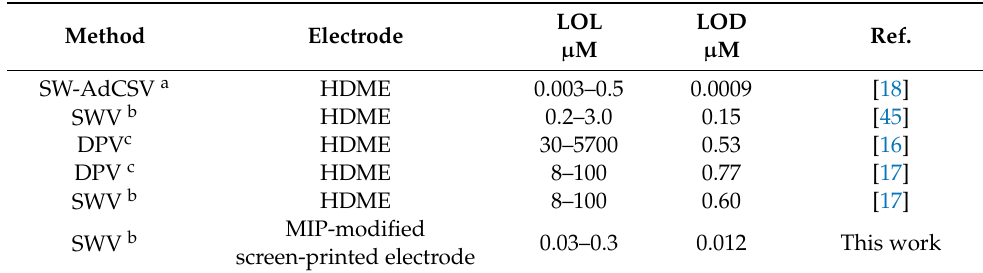
Table 9. Comparison of the analytical performances of electrochemical methods for Irbesartan detection.